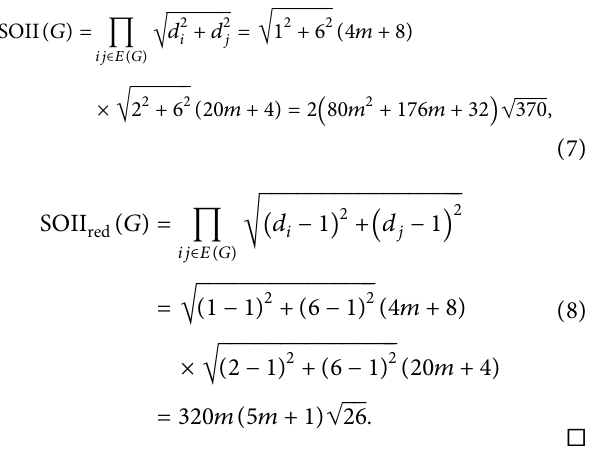
Figure 4: Bismuth triiodide sheet.